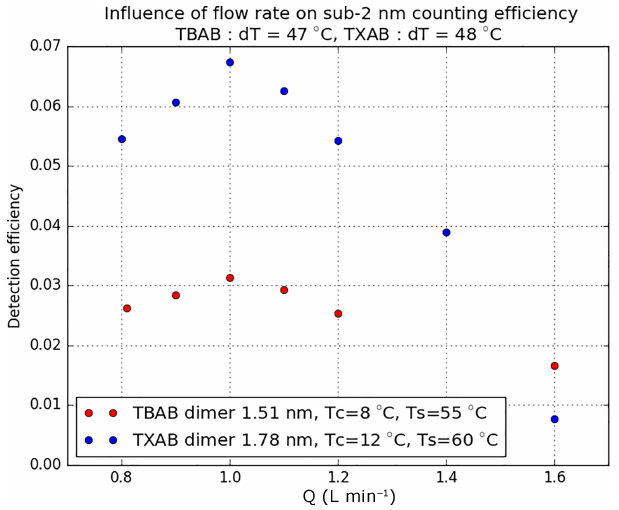
Figure 6. B3010 detection efficiency as a function of inlet pressure for two fixed-sized standards: TXAB monomer and dimer.